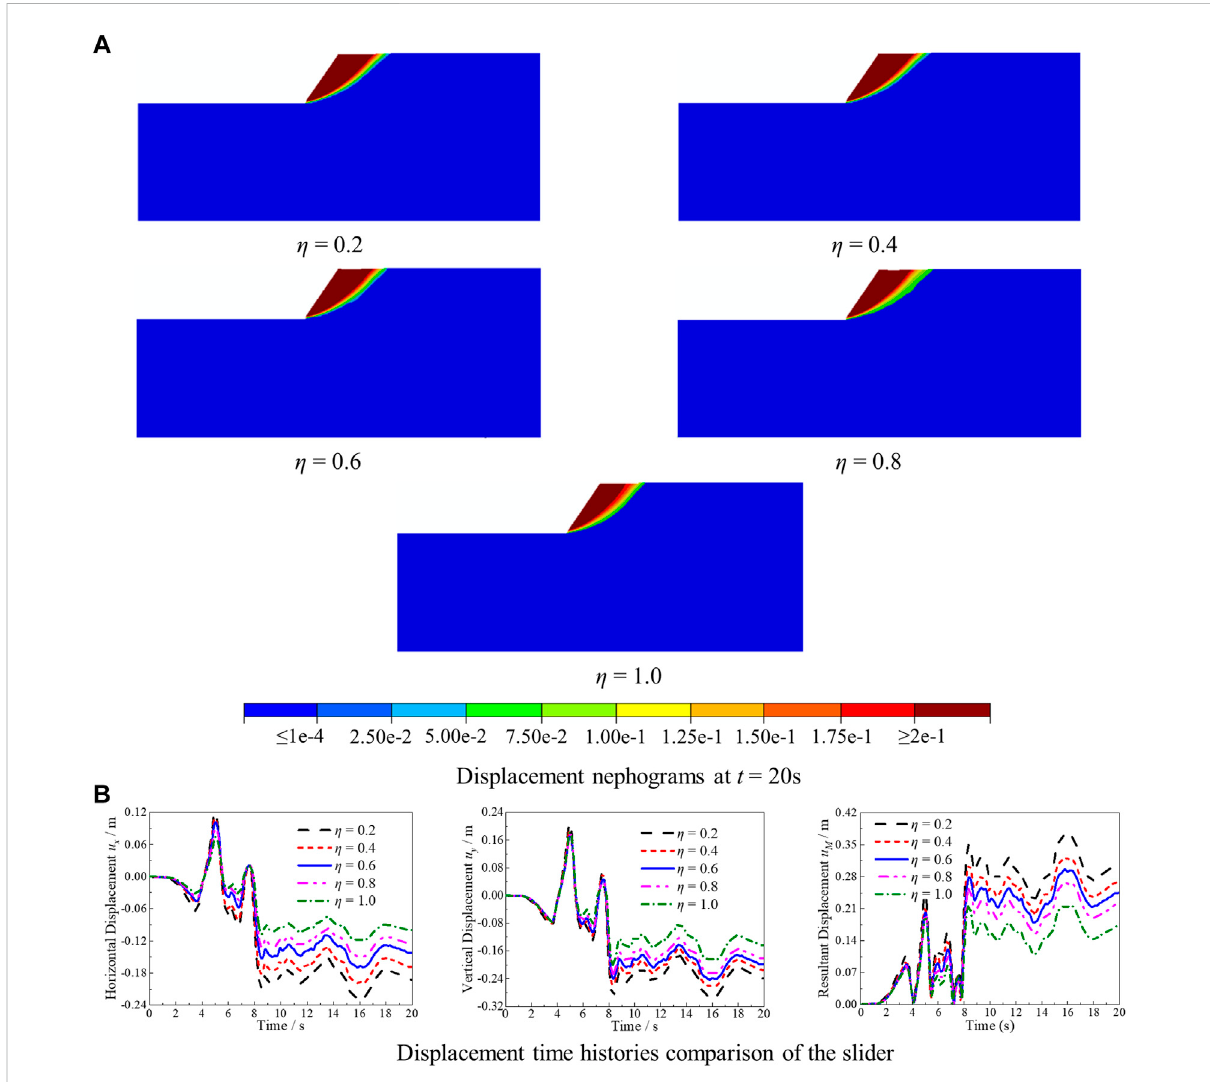
FIGURE 13 Displacementoftheslopeatdifferentimpedanceratios. (A) Displacementnephogramsat t =20 s. (B) Displacementtimehistorycomparisonof the